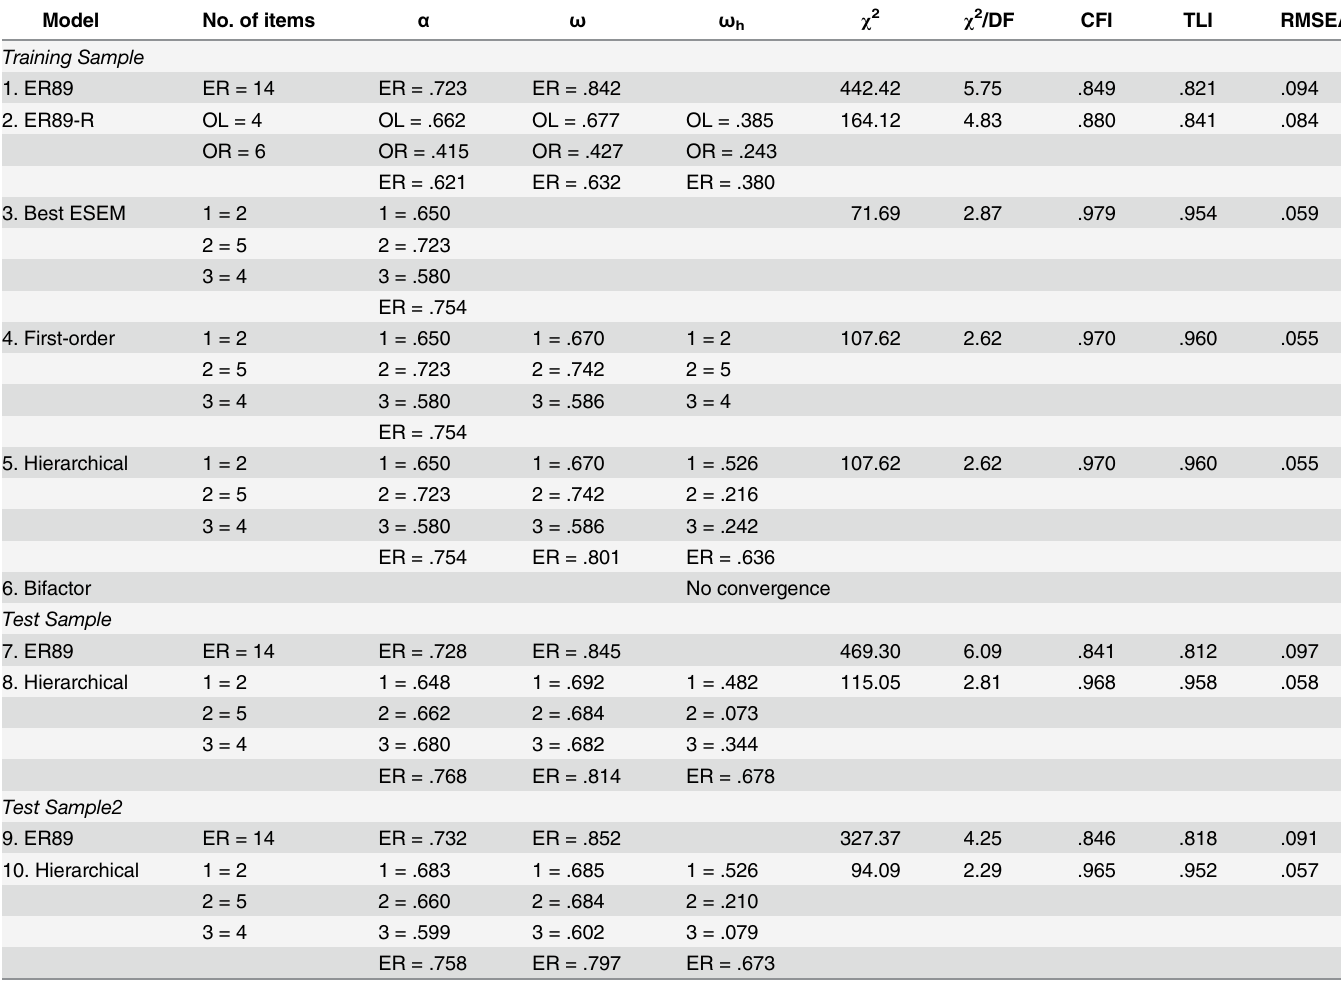
Table 1. Exploratory SEM and confirmatory factor analysis of the ego-resiliency scale.